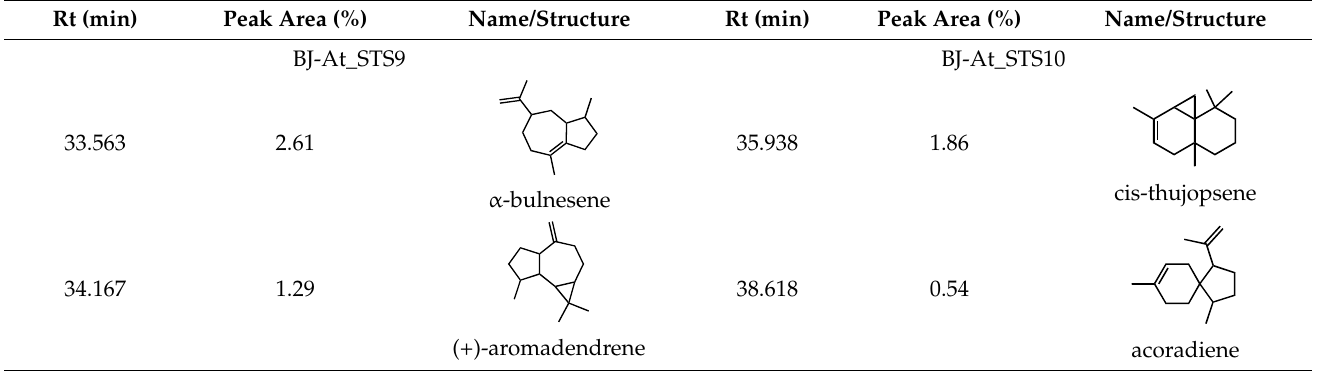
Table 3. Heterologous production of sesquiterpenes in yeast expressing STSs.